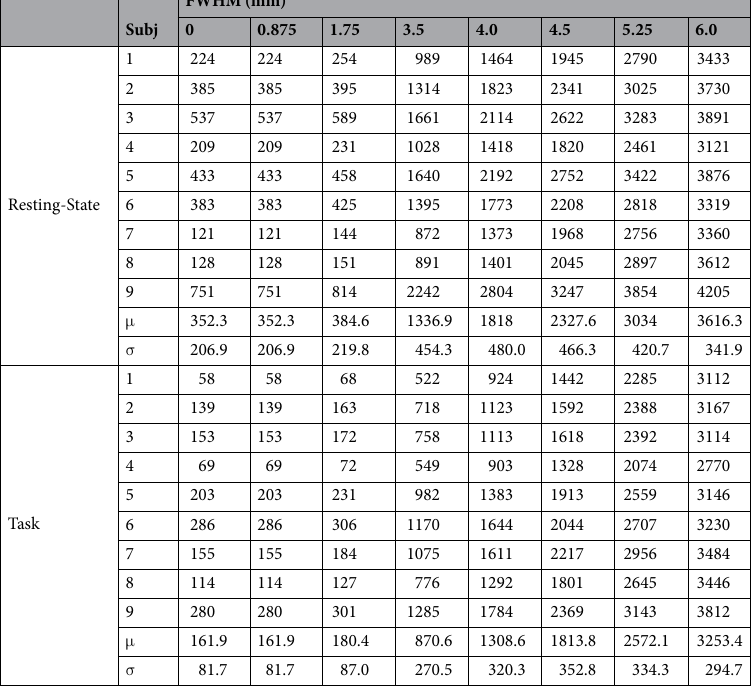
Table 2. The effects of the spatial smoothing on the detection of FAUPAs. Subj: subject. FWHM: full-width-